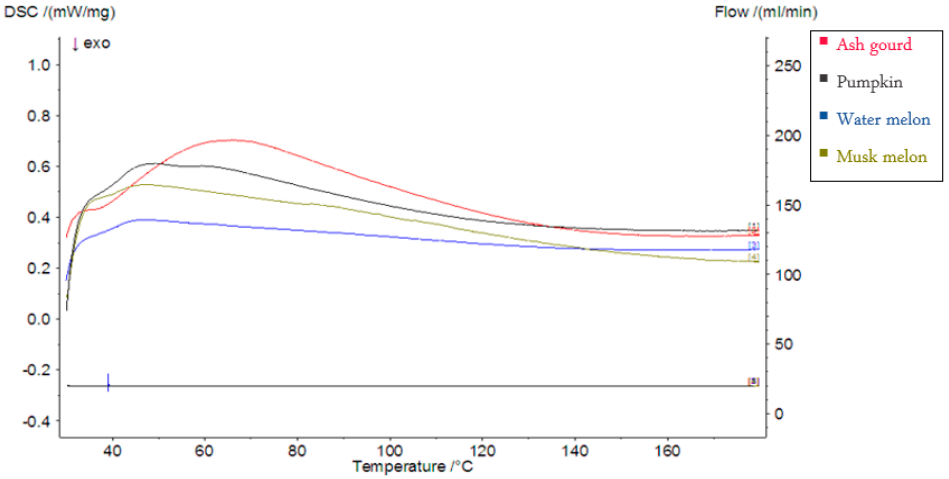
Figure 3. Thermal transition behavior of seeds.